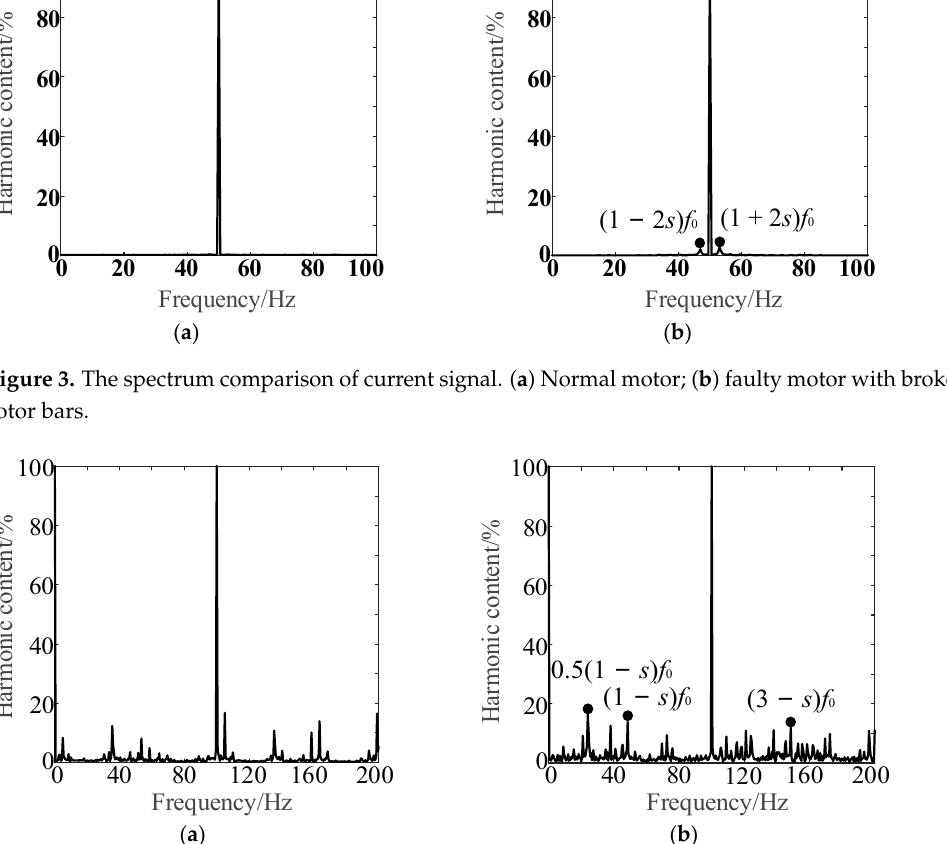
Figure 4. The spectrum comparison of radial electromagnetic force signal. ( a ) Normal motor; ( b ) faulty motor with broken rotor bars.